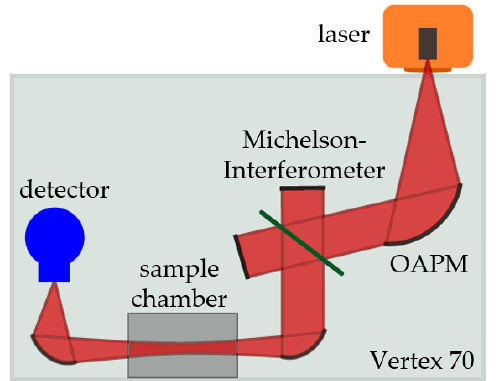
Figure 1. Schematic of the setup used for determining the emission characteristics of the QCL used in the present study. The QCL is essentially used as the light source in lieu of the black body emitter and modulated via the interferometer of the FTIR spectrometer. (Elements in the Figure not to scale). For analytical measurements, the experimental setups shown in Figure 2 were